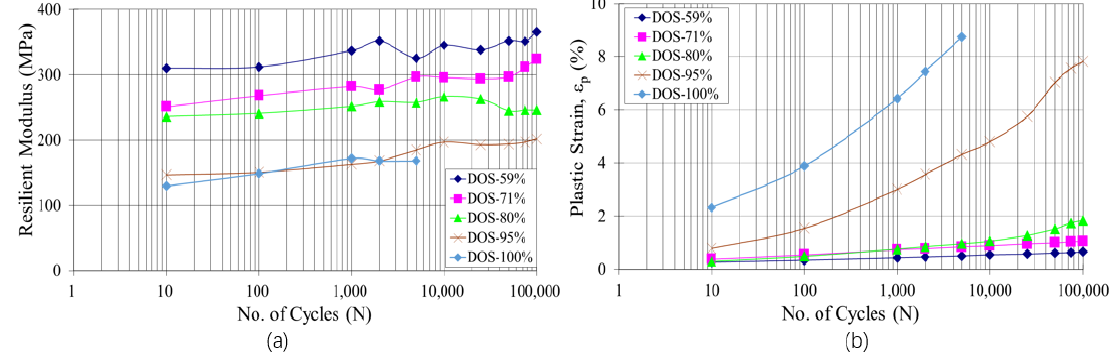
Figure 4. The relationship between dynamic response and the number of cycles with an applied deviator stress of 425 kPa: ( a ) resilient modulus; ( b ) plastic strain.